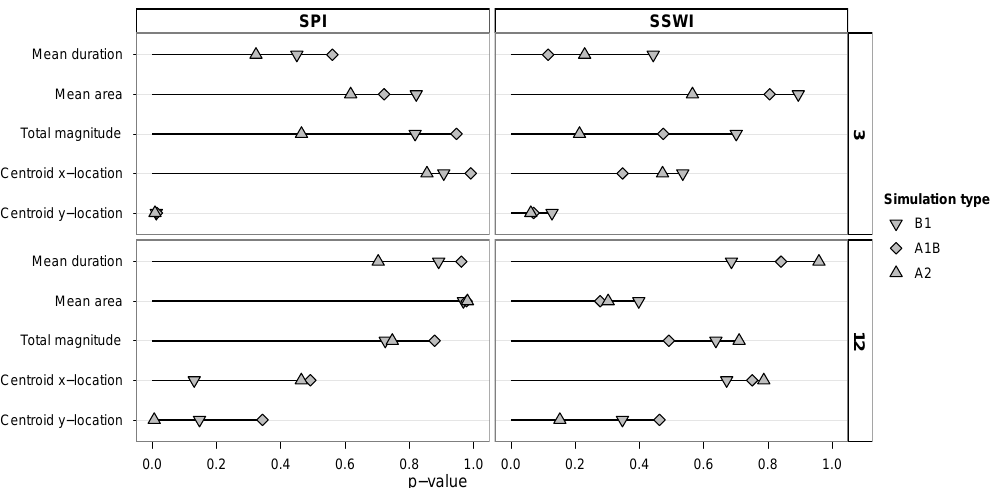
Fig. 6. Agreement between simulated and observed statistical distributions of drought characteristics (mean area, mean duration, total mag- nitude, centroid x - and y -location) over the 1958–2008 period. The agreement here is given as the p-value of the 2-sample Kolmogorov- Smirnov test between the observed distribution from the reanalysis and the corresponding distribution from a present-day simulation (CTRL+A2, A1B or B1) . Only “major events” are considered here (see Fig. 3). Columns show the 2 different indices and rows show the 2 different time scales.